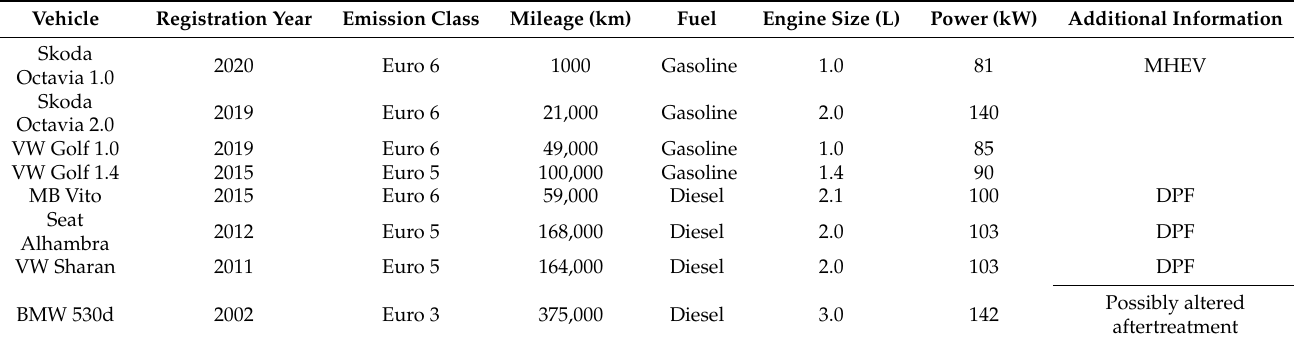
Table 1. Tested AH-containing vehicles with details. MHEV denotes mild hybrid electric vehicle, which uses an electric motor only for assisting the main engine and does not typically run alone.